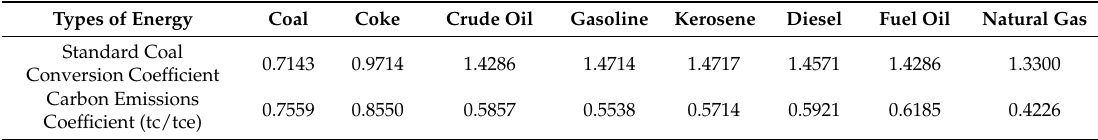
Table 2. The value of the energy conversion standard coal coefficient and carbon emission coefficient.